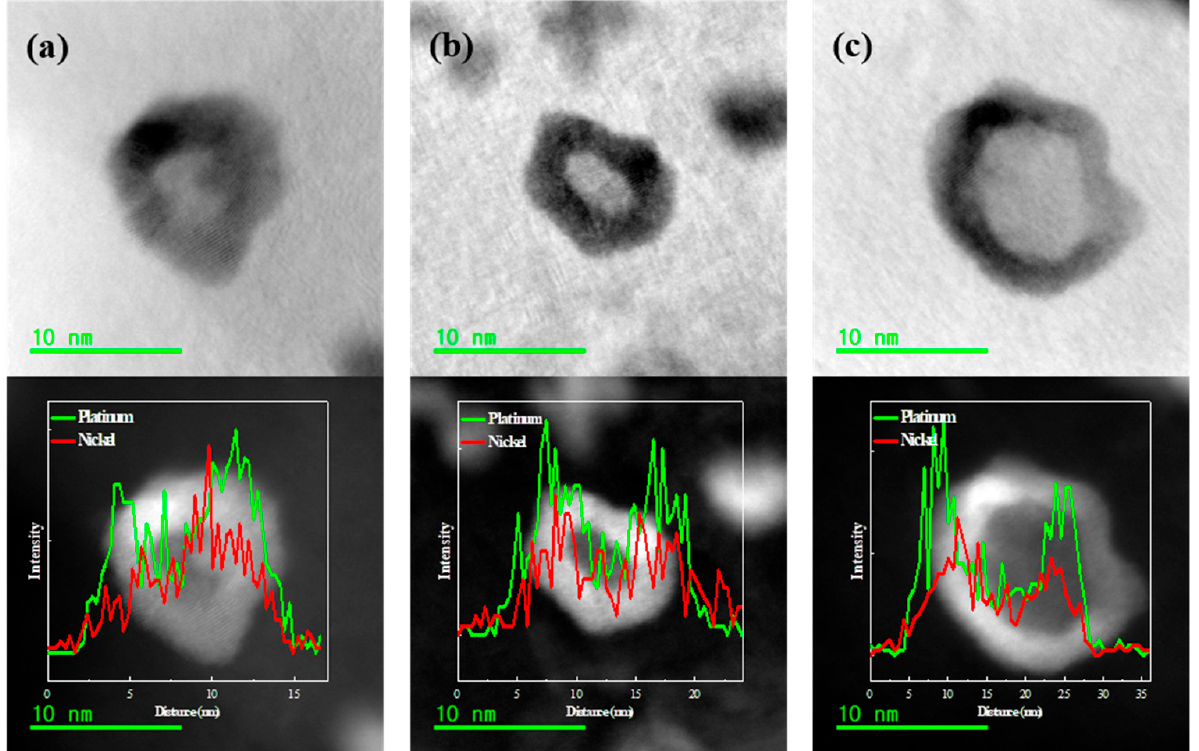
Figure 5. HR-TEM images and line-scan profiles of PtNi 3 /C-H at ( a ) 0 min, ( b ) 15 min, and ( c ) 30 min.